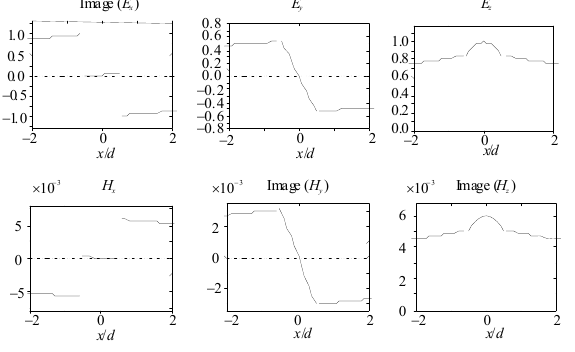
3 k d  for LCP even mode when 0